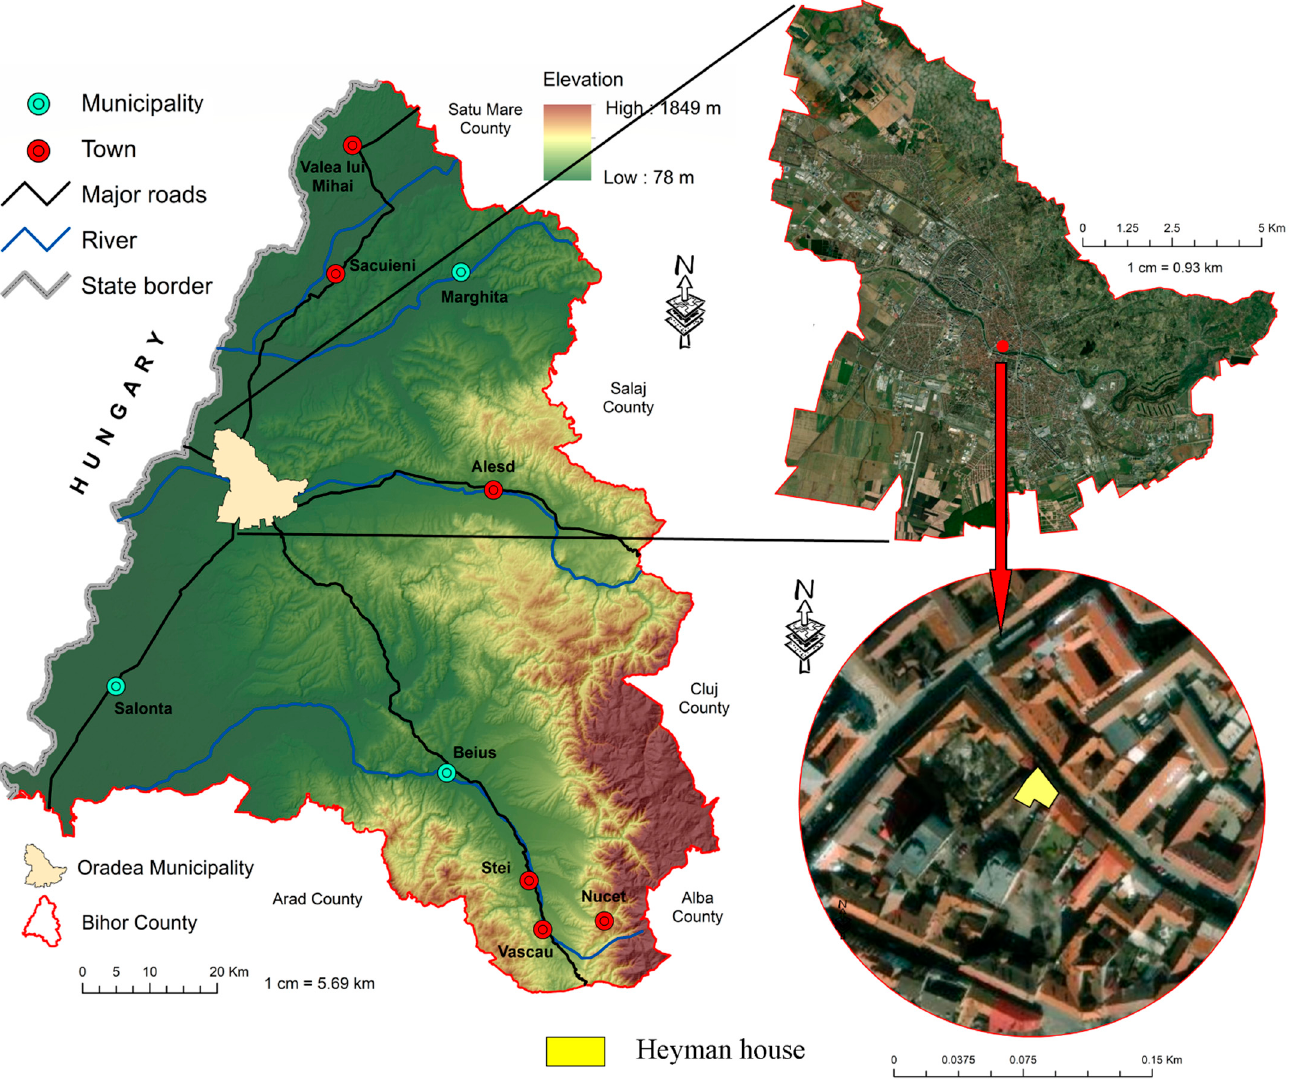
Figure 1. The location of the Heyman house at the county and the city of Oradea level.